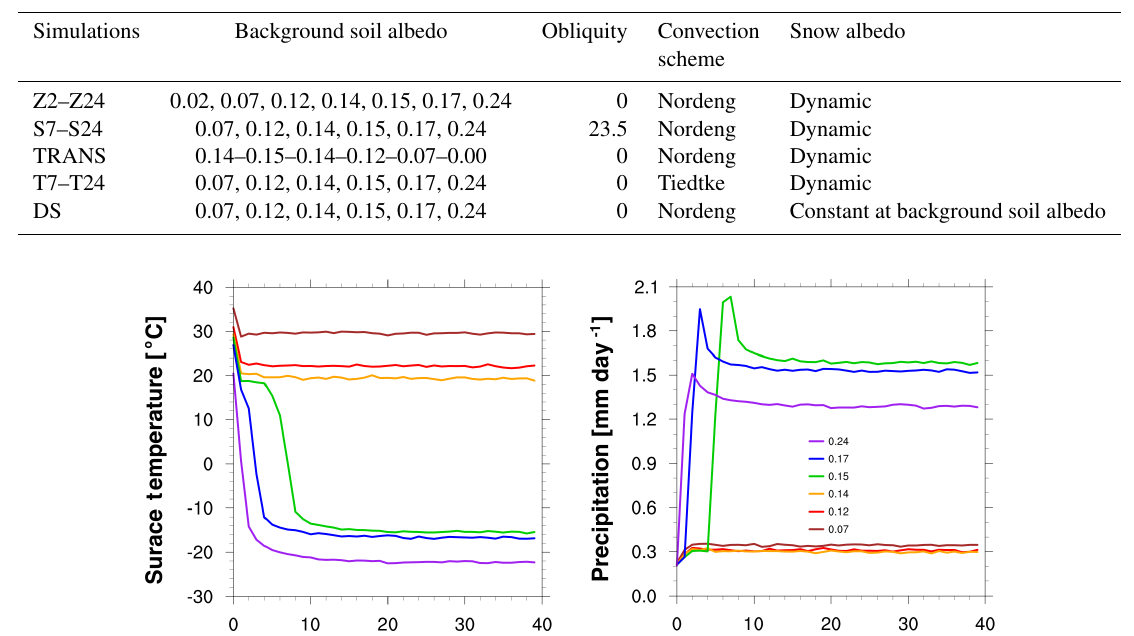
Table 1. Summary of simulations performed in this study.